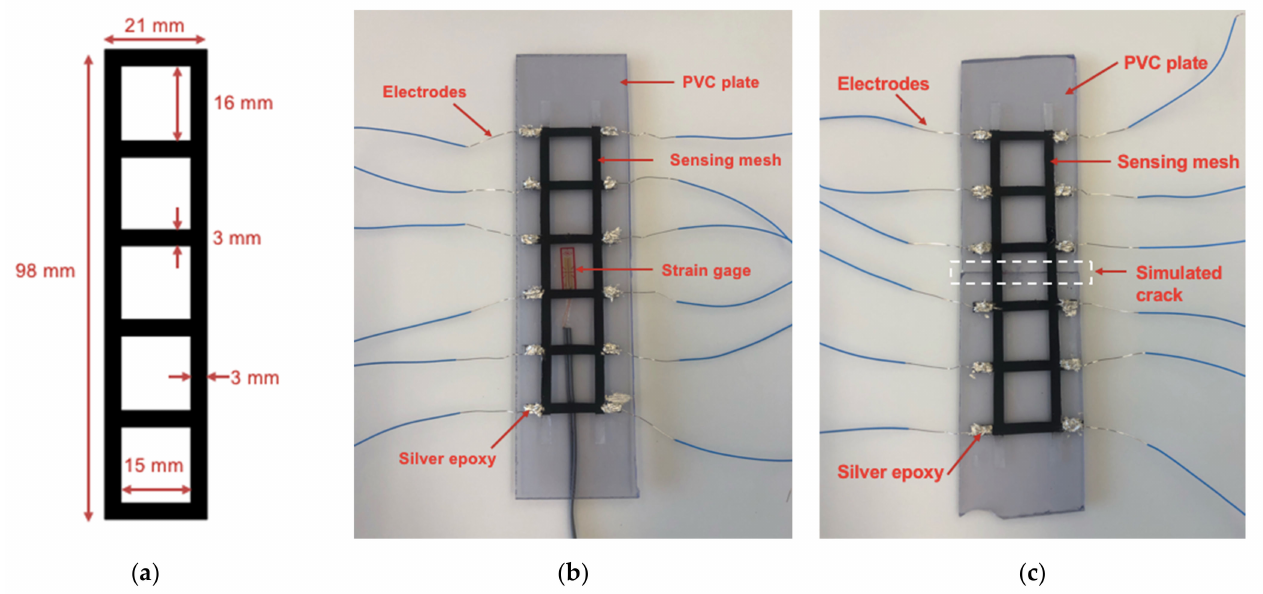
Figure 3. ( a ) TPU sheets were cut into grid-like patterns, followed by spray-coating nanocomposite paint to form sensing mesh specimens. Then, the sensing mesh specimens were affixed onto the PVC plate. ( b ) The sensing mesh was affixed onto an intact PVC plate for strain distribution monitoring, along with a strain gage mounted on the backside. ( c ) The sensing mesh was affixed onto a cracked PVC plate for crack detection tests.